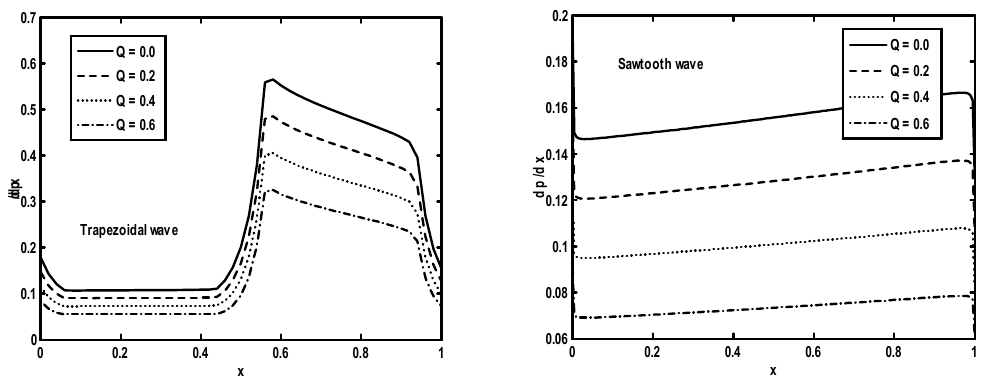
dxdp / Figure 9. Variation of dp / dx with x for di ff erent wave forms for fixed a = 0.9, α = 0.3, b = 0.1, Figure 9. Variation of with x for different wave forms for fixed π = 0.5, η = 0.4, λ = 0.5, k = 0.1. d = 2, Θ = π , Fr = 0.6, η , M = 0.5, Re = 0.4, ϕ = 3 4 1 2 1